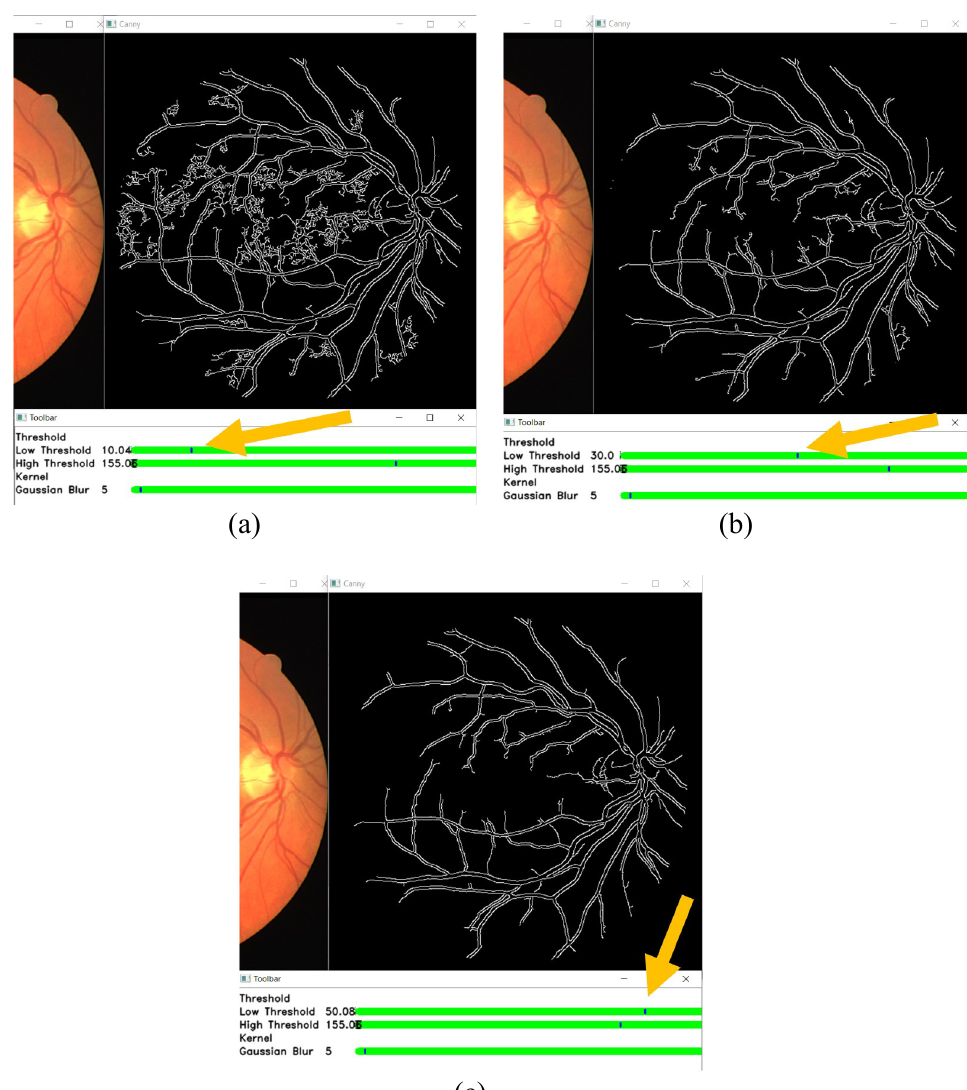
Figure 11. High threshold at 155, and low threshold at ( a ) 10 (the obtained PFOM value is 0.5941), ( b ) 30 (the obtained PFOM value is 0.5532), and ( c ) 50 (the obtained PFOM value is